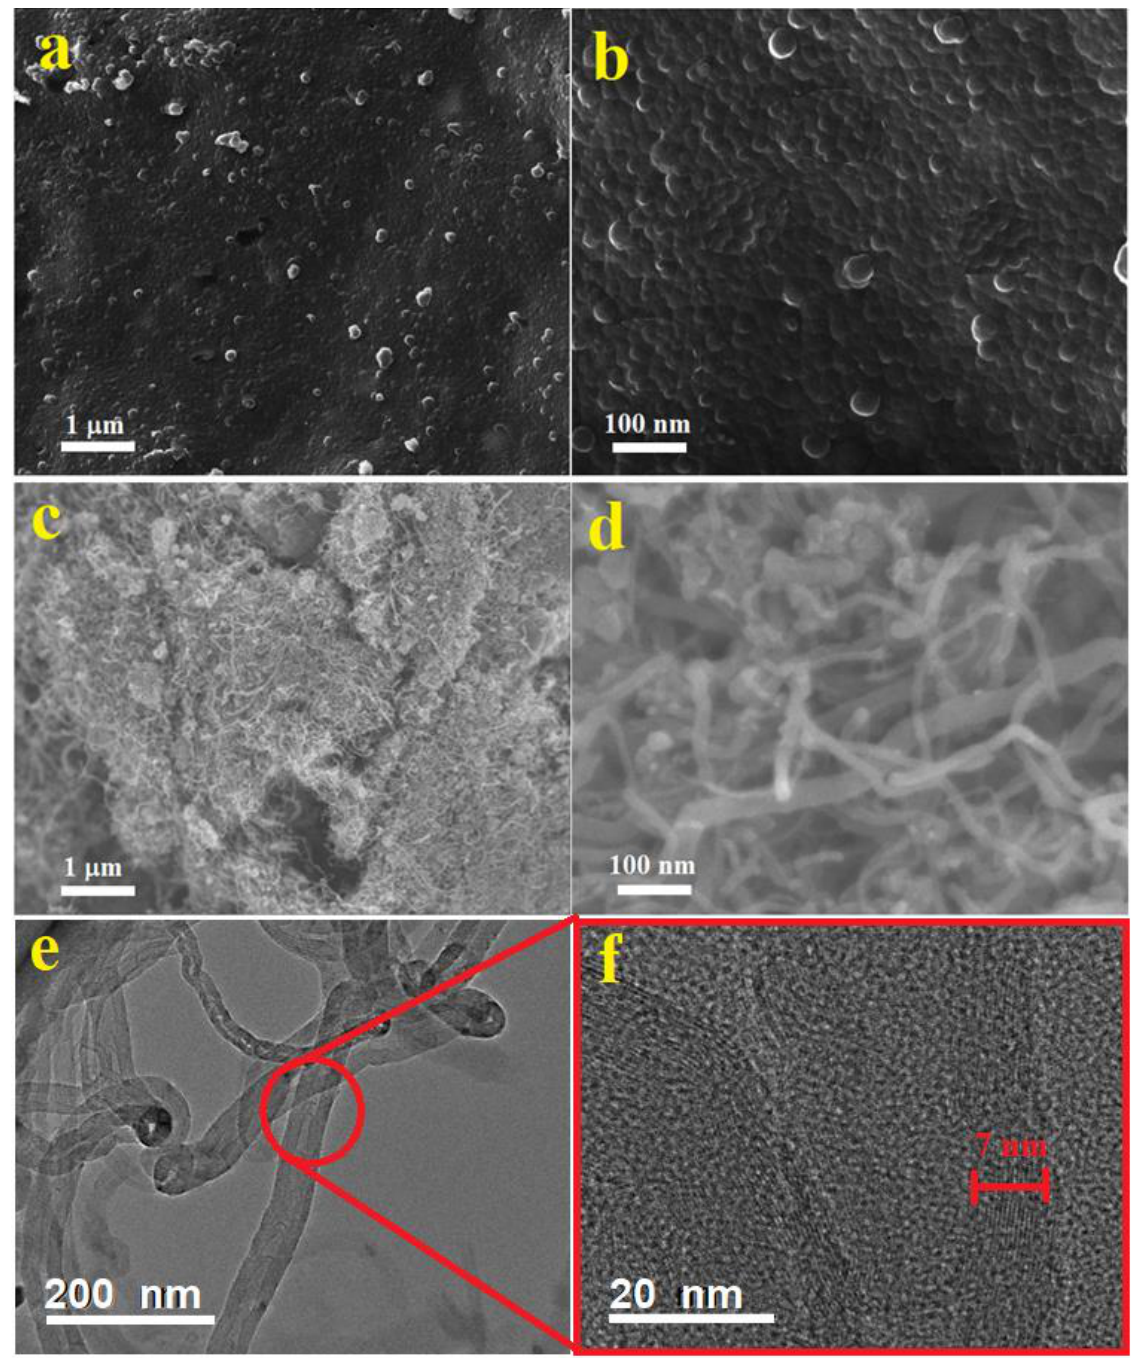
Figure 2. SEM images at two different magnifications of pure PPy ( a , b ), MWCNT ( c , d ). TEM ( e ) and HRTEM ( f ) images of MWCNTs are also shown.